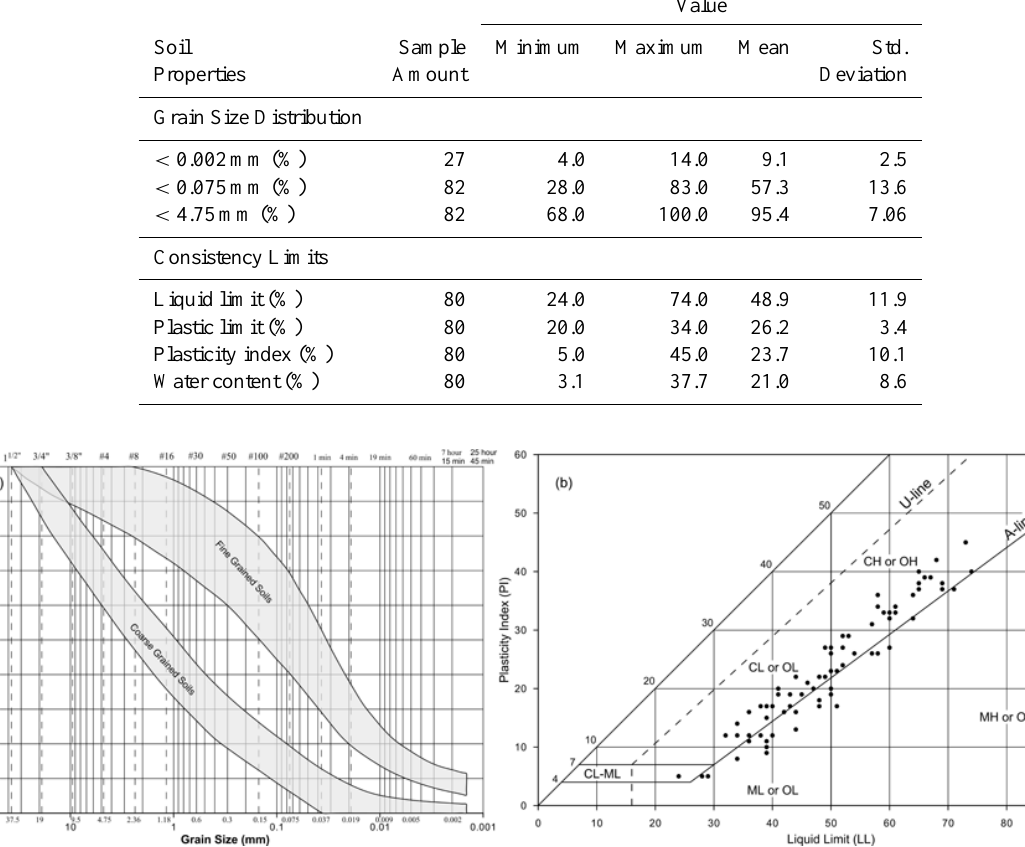
Fig. 5. Determination test performed on samples: (a) particle size distribution interval of fine–coarse grained soils and (b) position of the samples on a plasticity chart.